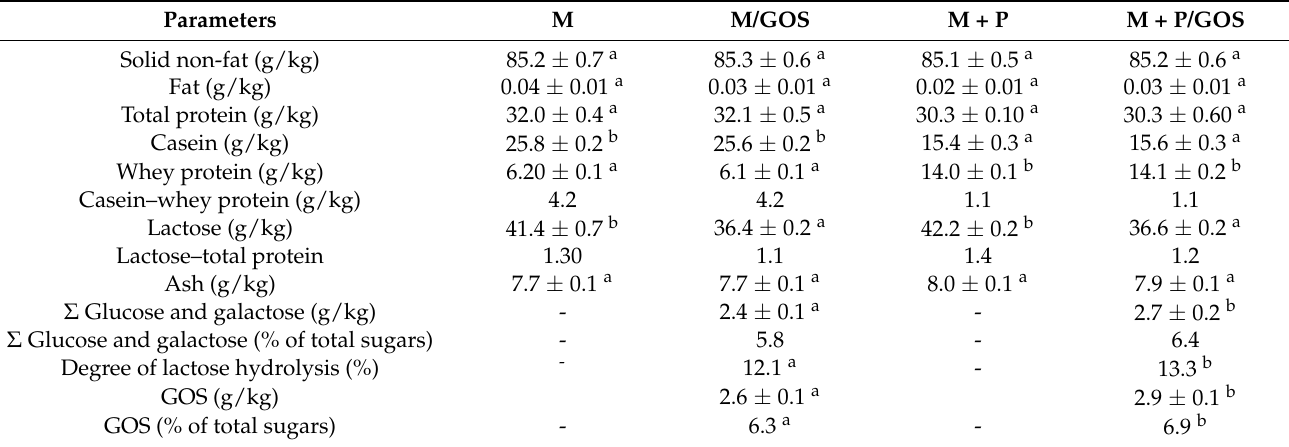
Table 1. Contents and amounts of components in goat’s milk and goat’s milk with permeate after enzymatic conversion of lactose.